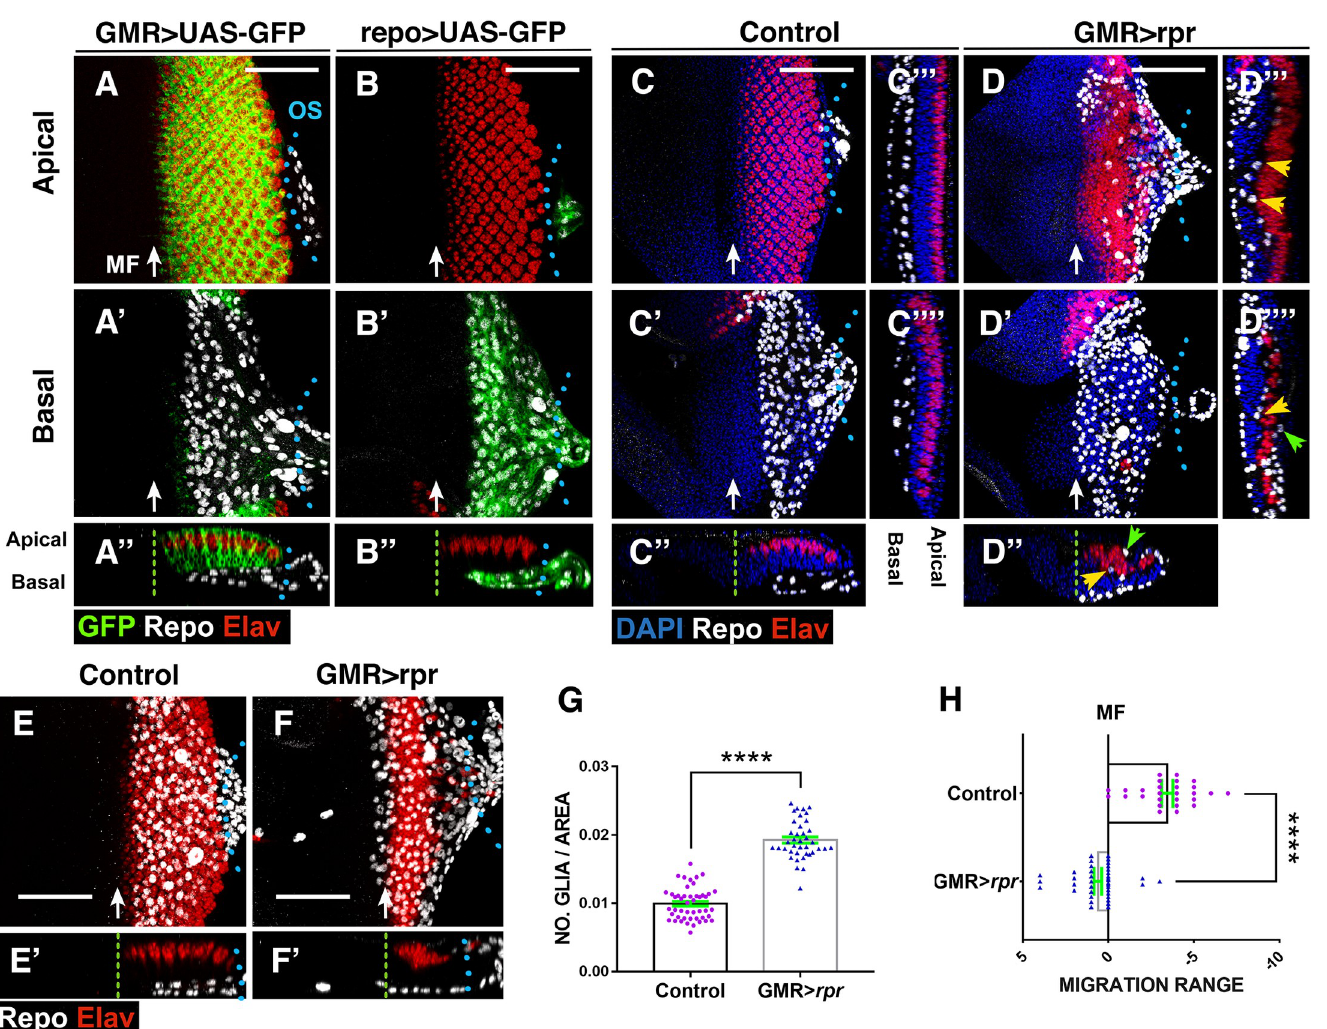
Fig 1. Response of glia to neuronal apoptotic induction in the eye discs. (A–F’) Third instar eye discs stained with anti-Elav (Photoreceptors in red), anti-Repo (glial cells in white), and the nuclear marker DAPI (blue). (A–D) Apical/middle layers of the eye disc epithelium. (A’–D’) Basal layers of the eye discs. (A”–D”, E’–F’) The X– Z projections show cross sections perpendicular to the furrow of the eye discs of panels A–D (A”–D”) and E–F (E’–F’). (C”’–C”” and D”’–D””) Transverse sections parallel to the furrow of discs shown in C (C”’–C””) and D (D”’–D””). (A–A”) Eye disc showing the expression of UAS-GFP (green) under the control of GMR-Gal4 . Glial nuclei (anti-Repo in white) are located in the basal layer of the eye disc, and they do not express UAS-GFP . (B–B”) The expression of UAS-GFP (green) under the control of repo-Gal4 is restricted to glial cells. (C–C””) In control discs, subretinal glial cells are always located in the basal layer of the disc. (D–D””) In damaged UAS- rpr/+ GMR-Gal4 , tub-Gal80 ts eye discs glial cells are not only in the basal layer of the disc but also in the middle and apical layers. This is most clearly seen in transverse sections shown in (D”–D””). Arrowheads indicate glial cells located in apical (green arrowheads) and middle (yellow arrowheads) layers of the discs (D”– D””). Note that glial cells in the medial layer directly contact photoreceptors. (E–F’) Projections of confocal images of the basal layers of third instar control ( GMR-Gal4 tub-Gal80 ts ) (E) and damaged ( UAS-rpr/+ GMR-Gal4 , tub-Gal80 ts ) (F) eye showing the relative position of the anterior border of glial migration with respect to the anterior most row of photoreceptors. In damaged discs, the anterior border of glial migration lays 2–4 row in front of the MF (green dashed line). (G) Graph shows the density of glial cells (number of glial cells/area occupied by glial cells in μ m 2 ) in control and damaged UAS-rpr/+ GMR-Gal4 tub-Gal80 ts /+ discs. (H) Graph shows the relative position of the anterior border of glial migration with respect to the anterior most row of photoreceptors (0 indicates the position of this row) in control and damaged UAS-rpr/+ GMR-Gal4 tub-Gal80 ts eye disc. Error bars represent SEM. Statistical analysis is shown in Table A in S1 Text. In this and all subsequent figures, anterior is to the left. Blue dotted lines indicate the approximate limit between eye disc and optical stalk (os). The green dashed line indicates the approximate position of the MF. Scale bars, 50 μ m. The numerical data used in this figure are included in S1 Data. GMR, glass multiple reporter; MF, morphogenetic furrow; rpr , reaper ; SEM, standard error of the